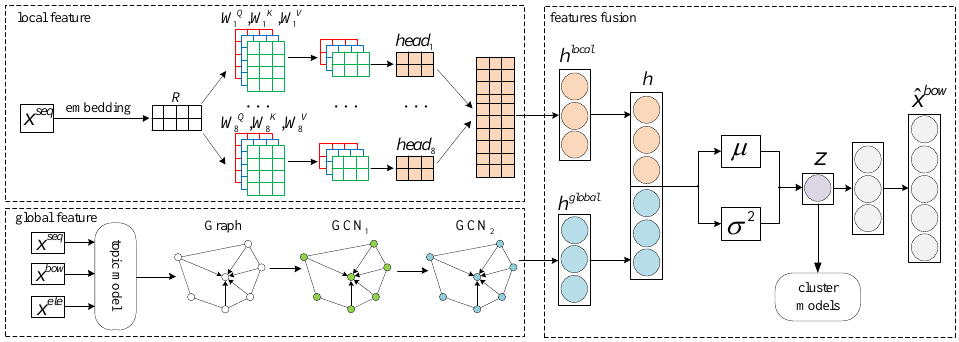
Figure 2. Overall framework of the proposed method.